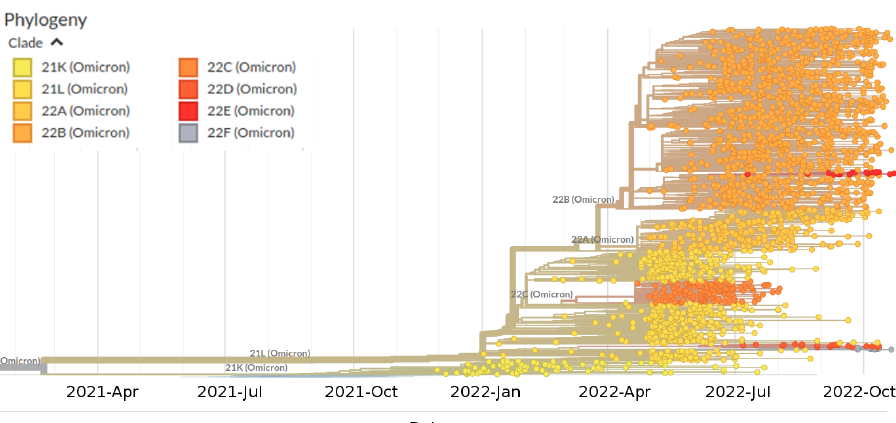
Figure 1. Highlight of the Omicron clade (GSAID Clade 21L) in the time-scaled phylogenetic tree of a representative global subsample of 2809 SARS-CoV-2 genomes sampled between January 2022 and November 2022. Phylogeny has been reconstructed using nextstrain/ncov (https://github.com/nextstrain/ncov, accessed on 9 November 2022), available at https://gisaid.org/phylodynamics/global/nextstrain/, accessed on 9 November 2022. The figure has been edited using the software GIMP 2.8 (available at https://www.gimp.org/downloads/oldstable/, accessed on 9 November 2022). See Table 1 for details on Nextstrain clade, Pango lineage and WHO labels.